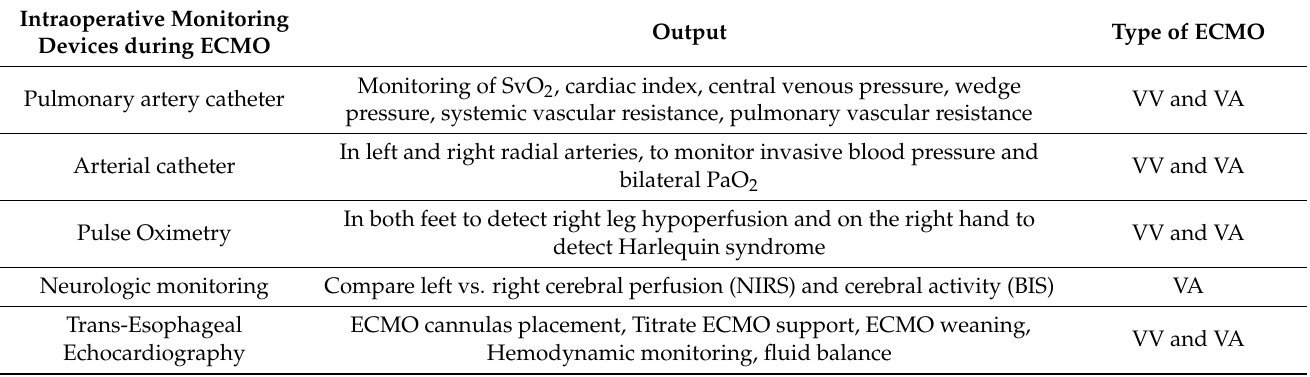
Table 2. Intraoperative monitoring during VV and VA